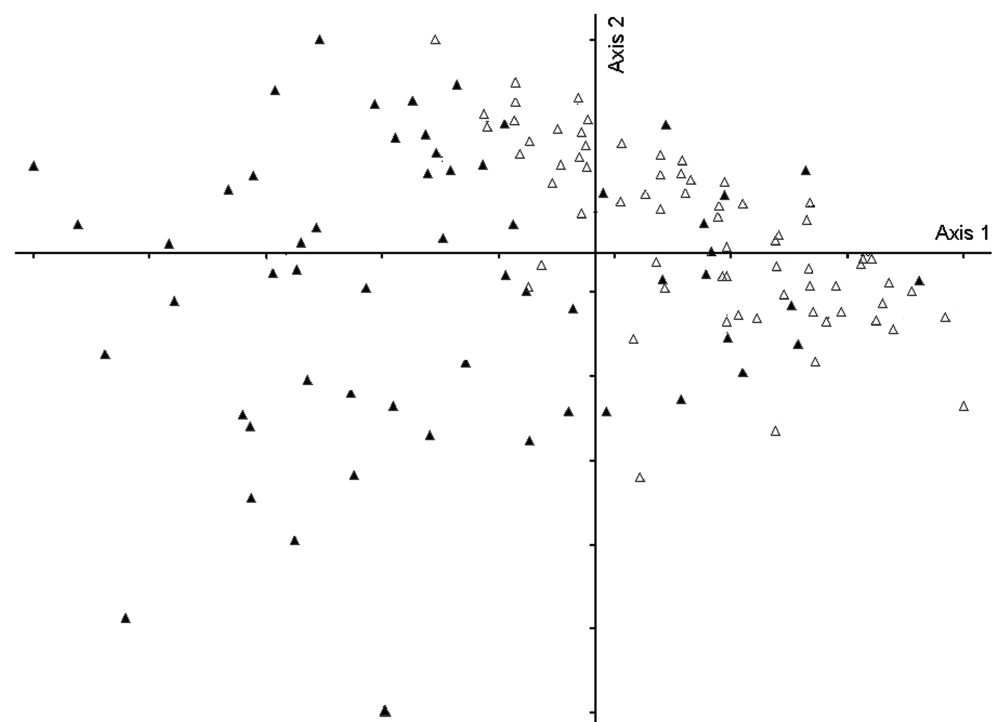
Figure 4 - Biplot graph showing the separation between irrigated and drainage sites in